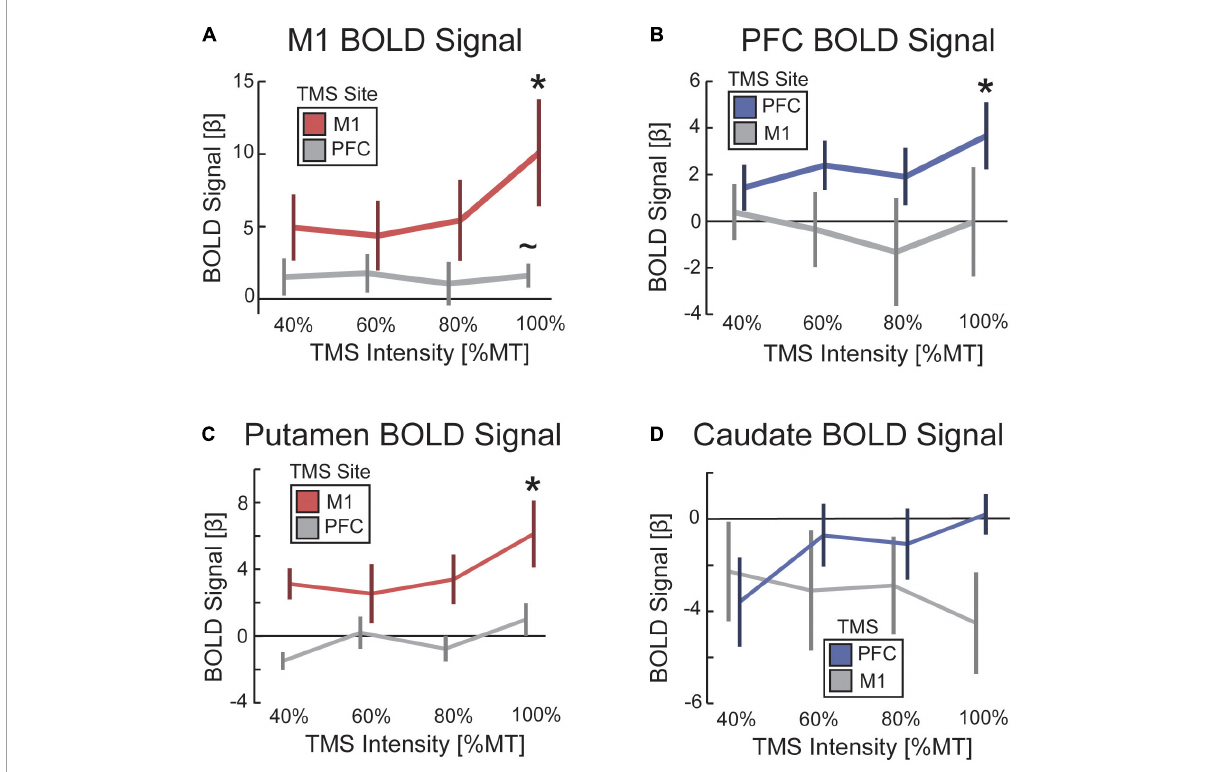
FIGURE5 TMS increased evoked BOLD activity as a function of TMS intensity. The impact of TMS on the BOLD signal as a function of TMS intensity for (A) M1, (B) PFC, (C) putamen, and (D) caudate. Color-coding reflects conditions hypothesized to demonstrate a parametric increase in BOLD signal with TMS intensity. Red denotes TMS to M1 when reporting the BOLD signal in M1 and putamen. Blue denotes TMS to PFC when reporting BOLD signal in PFC and caudate. Error bars are standard error to the mean. * p < 0.05. ∼ p < 0.1.